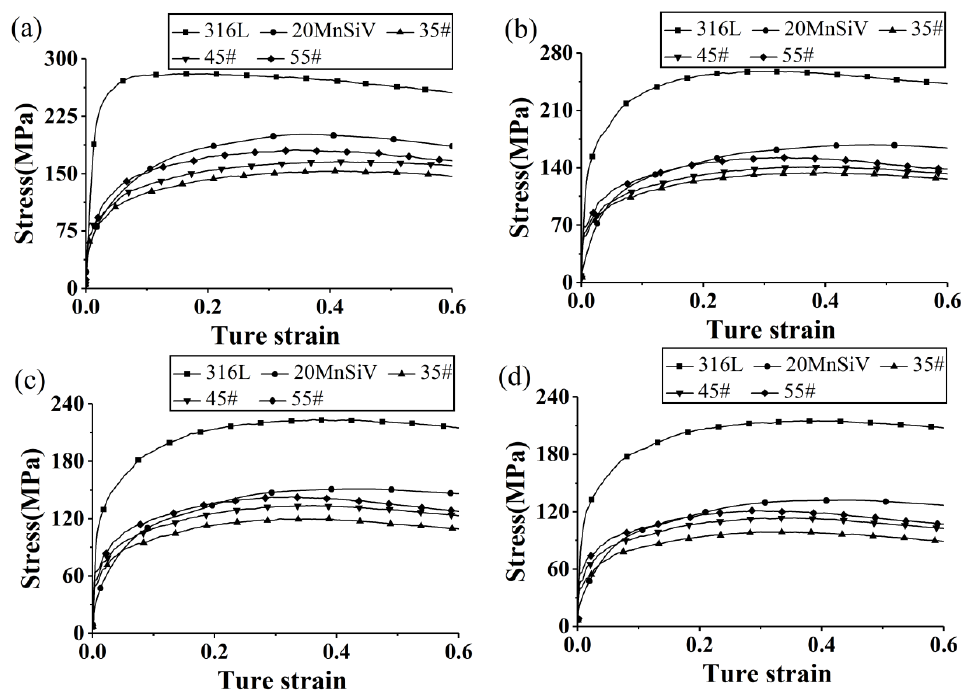
Figure 6. Stress–strain curves of the base and clad materials at different temperatures: ( a ) 950 °C; ( b ) 1000 °C; ( c ) 1050 °C; ( d ) 1100 °C.